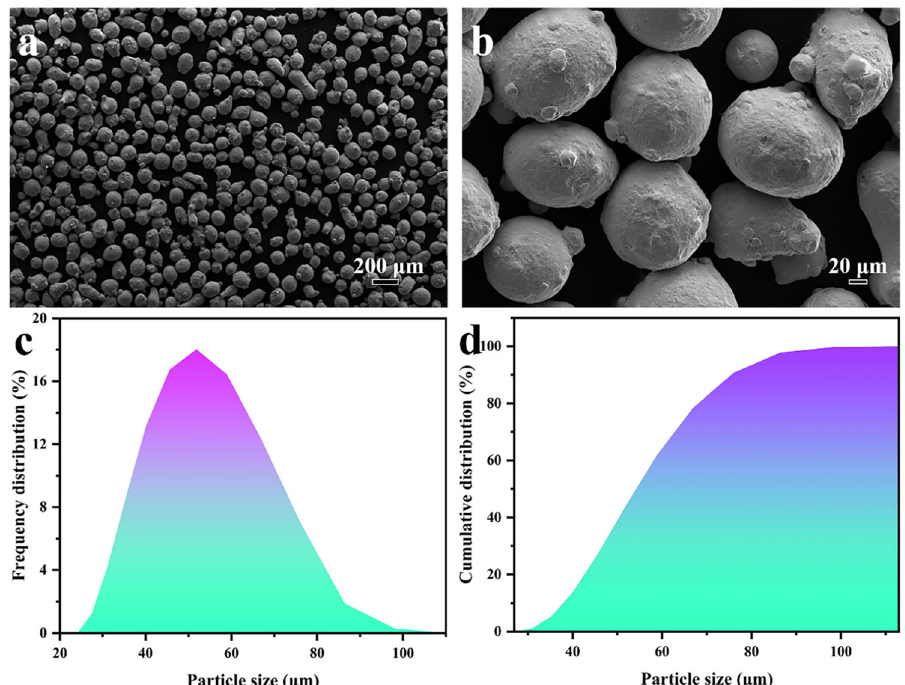
Fig. 10 Microstructure and particle size distribution of Inconel 625 powder. a FESEM image; b locally magni fi ed FESEM image of the a ; c , d particle size